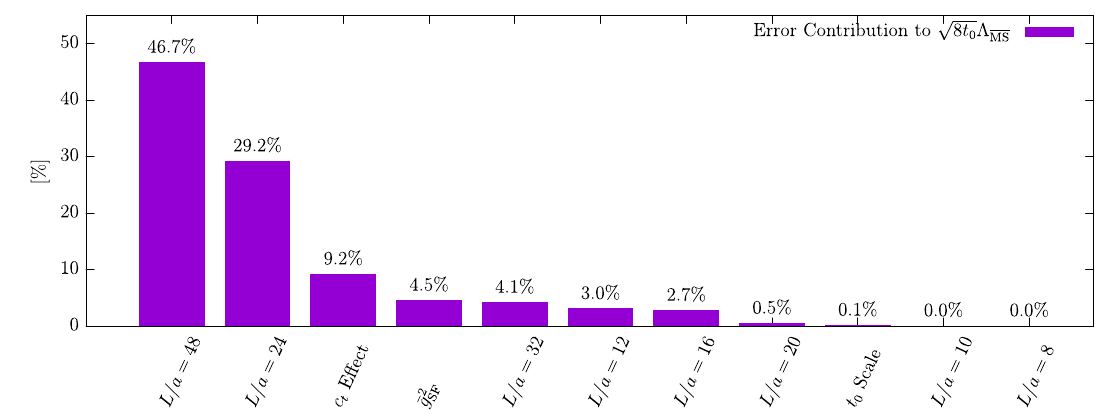
√ 8 t 0 (cid:3) , terms (labelled c t effect) is only a small fraction of the error. Also the MS simulations that determined the SF coupling (labelled ¯ g 2 contribution to the error